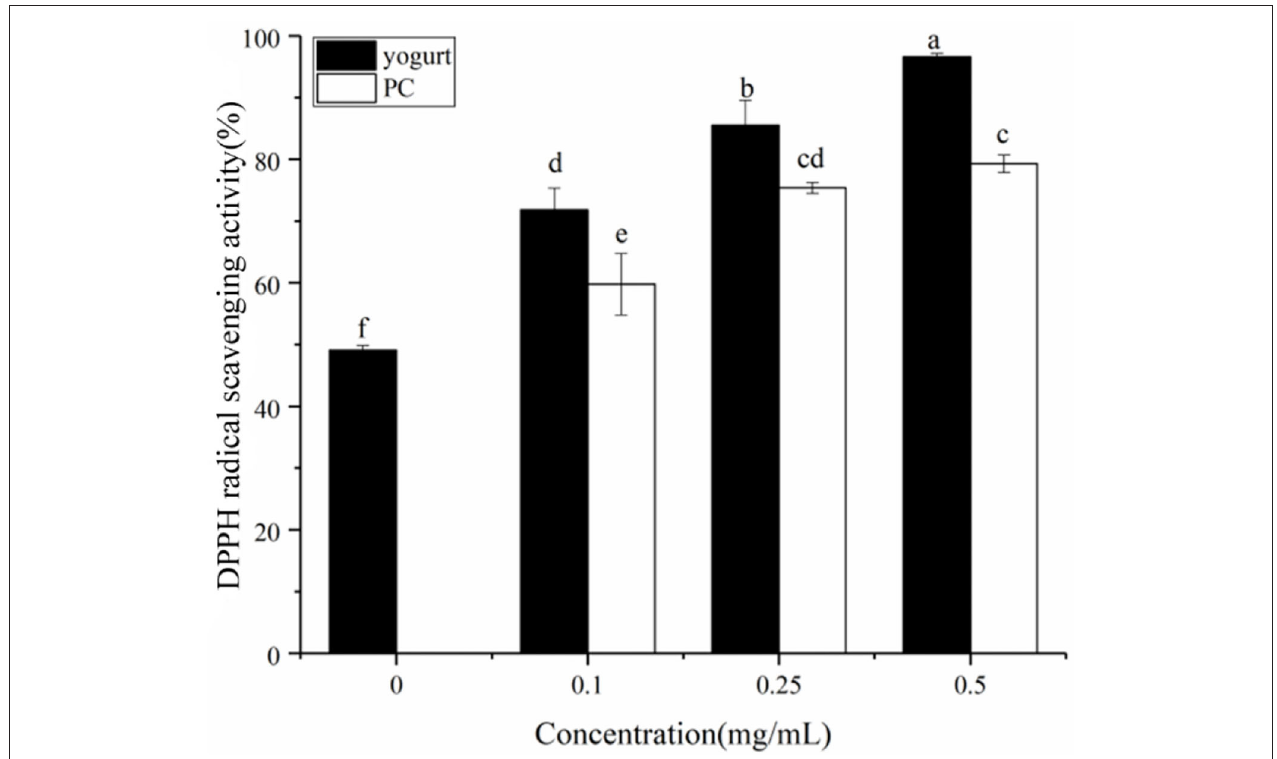
FIGURE 6 | DPPH free radical scavenging by yogurt containing procyanidin and yogurt without procyanidin (solid cylinder). The free radical scavenging rate of procyanidin themselves was also presented as a control (hollow cylinder). Different letters indicated significant differences ( P <